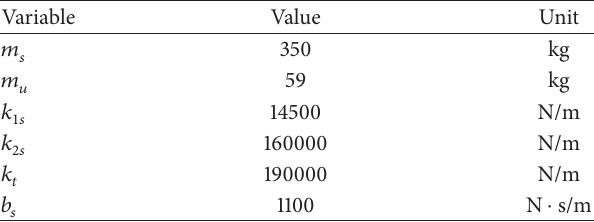
Table 1: Parameters and values of quarter-car